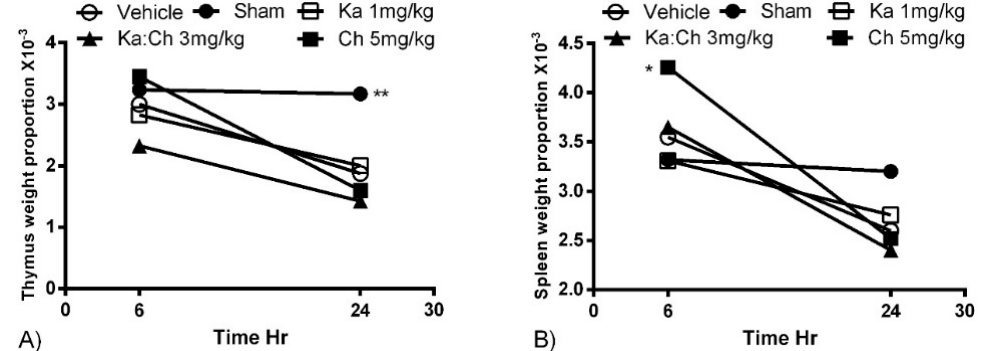
Figure 3. The effects of kaempferol and chrysin individual and combination treatments on mean organ weight proportions 6 and 24 h after CLP. Organs directly weighed after sacrificing the mice. ( A ) Thymus and ( B ) spleen. Each point represents the mean of four experiments. * p ≤ 0.05 and ** p ≤ 0.01 versus CLP/vehicle (Student’s t -test).